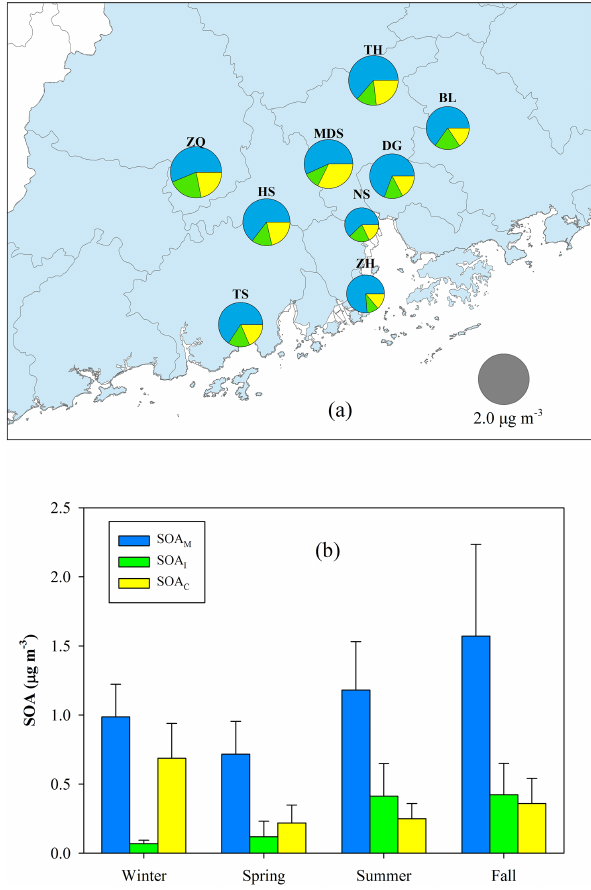
Figure 10. Spatial (a) and seasonal (b) variations in BSOA compo-